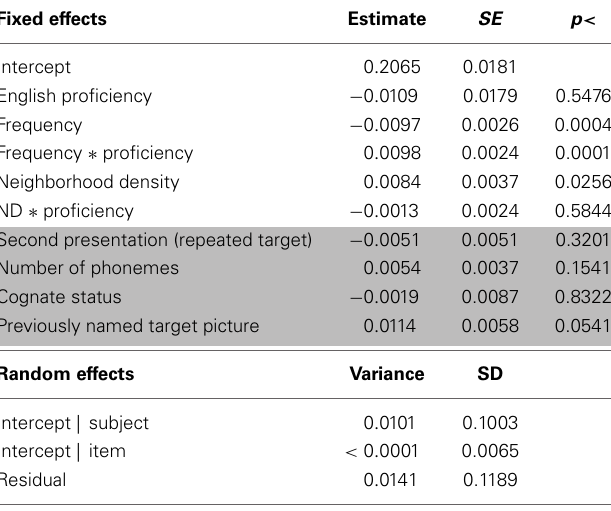
amplitudes—bilingual